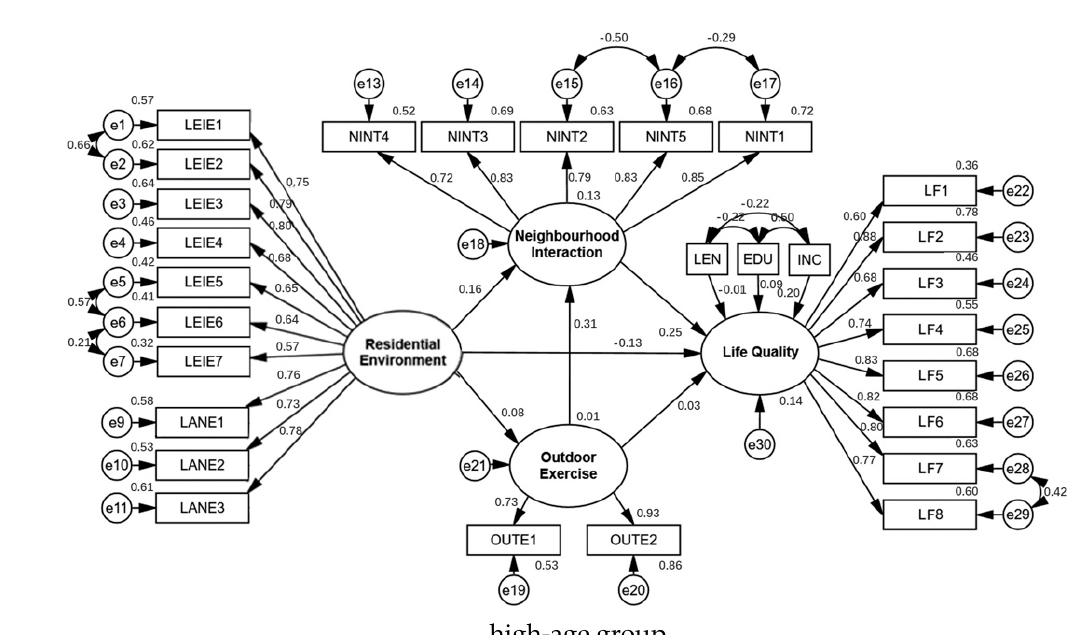
Table 4. comparison of the model paths in different age groups.